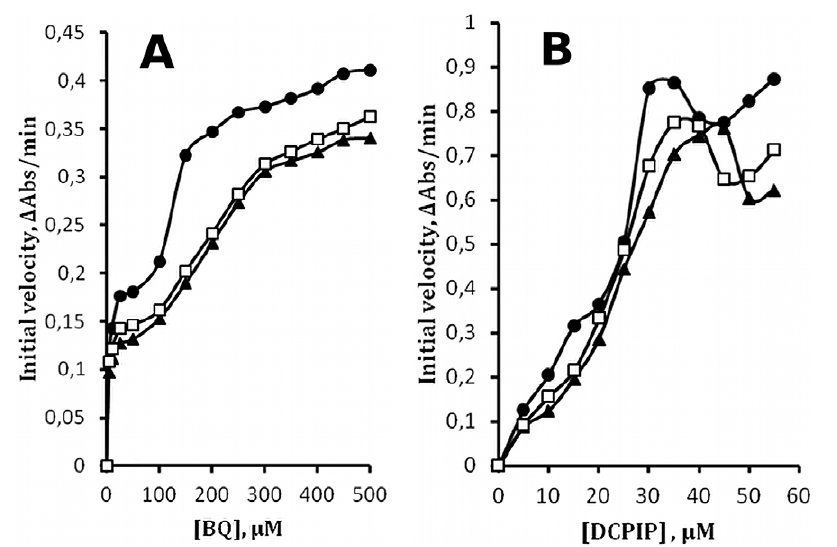
Figure 2. Effect of salt. Initial velocities at 5 u C are plotted vs. substrate concentration. A. Titration of BQ at [NADH]=100 m M with no salt (circles), 0.25 M NaCl (squares), and 0.5 M NaCl (triangles). B. Titration of DCPIP at [NADH]=100 m M; symbols as in panel A. Solid lines are intended only to guide the eye and do not represent fits to the data.